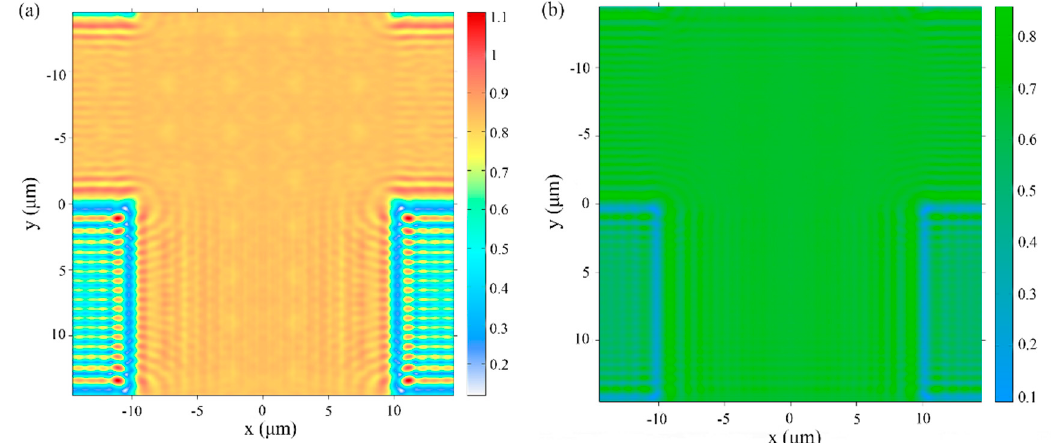
Figure 9. The corresponding reflection spectra of the letter T with different nanostructures. ( a ) The reflection spectra of letter T with D = 190 nm and p = 290 nm for every nanostructure, λ varies from 600 nm to 680 nm. ( b ) The reflection spectra of letter T with D = 115 nm and p = 290 nm for every nanostructure, λ varies from 500 nm to 560 nm. ( c ) The reflection spectra of letter T with D = 100 nm and p = 190 nm for every nanostructure, λ varies from 450 nm to 510 nm.